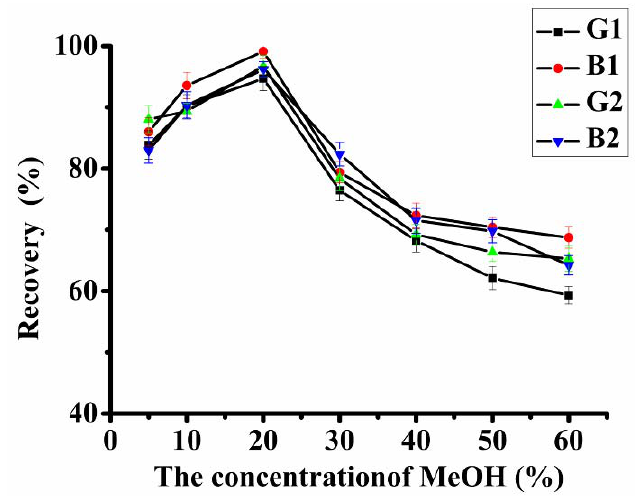
Figure 2. Effect of different loading solvents on the efficiency of IAC (aflatoxins spiked in peanut, 5 μ g·kg − 1 each).